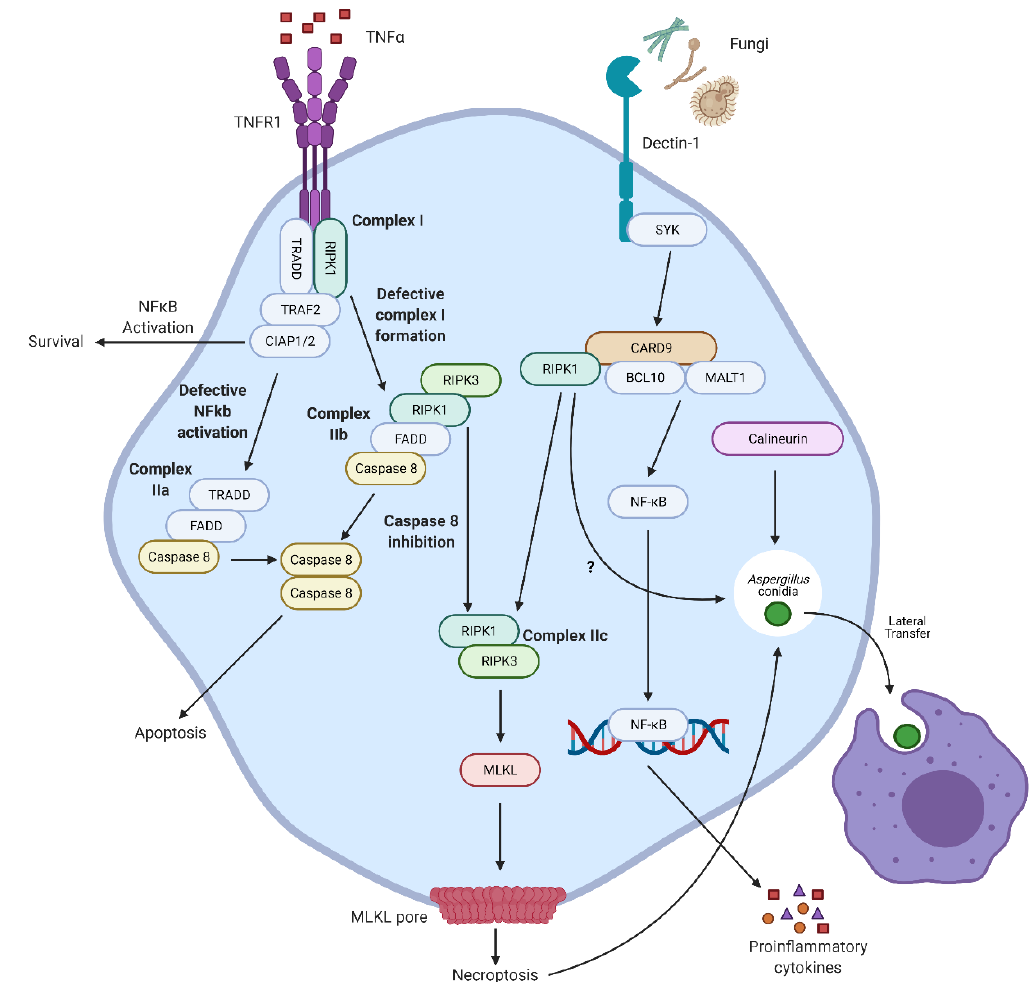
Figure 3. Fungal induction of necroptosis. Canonical necroptosis occurs through the recognition of tumor necrosis factor (TNF)- α by TNF receptor 1 (TNFR1). In the absence of caspase-8, receptor-interacting serine/threonine-protein kinase (RIPK)-1 is allowed to phosphorylate RIPK3 which in turn phosphorylates mixed-lineage kinase domain-like (MLKL). Phosphorylated MLKL oligomerizes and translocates to the cell membrane forming pores leading to lytic death, and therefore, the release of pro-inflammatory cytokines and damage-associated molecular patterns (DAMP). Necroptosis can be induced in response to fungi through recognition by the main fungal pattern recognition receptor dectin-1. In this pathway, caspase recruitment domain-containing protein 9 (CARD9) downstream of dectin-1 interacts with RIPK1, allowing it to phosphorylate RIPK3 and in turn the phosphorylation of MLKL, leading to necroptotic death through the specific recognition of fungi. Of note, germination of phagocytosed A. fumigatus conidia can lead to calcineurin-dependent lateral transfer from the infected macrophage undergoing necroptosis to a healthy macrophage to aid in fungal control, a process termed metaforo- sis.